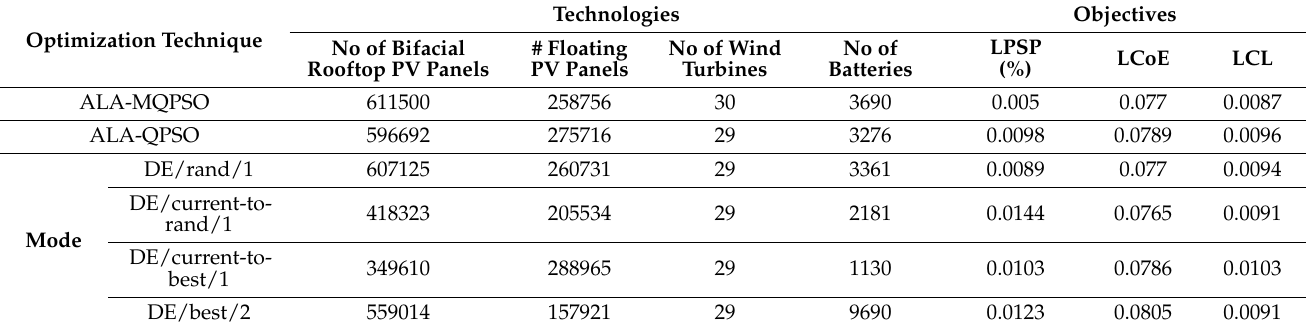
Table 5. Results for optimal sizing with the adopted optimization